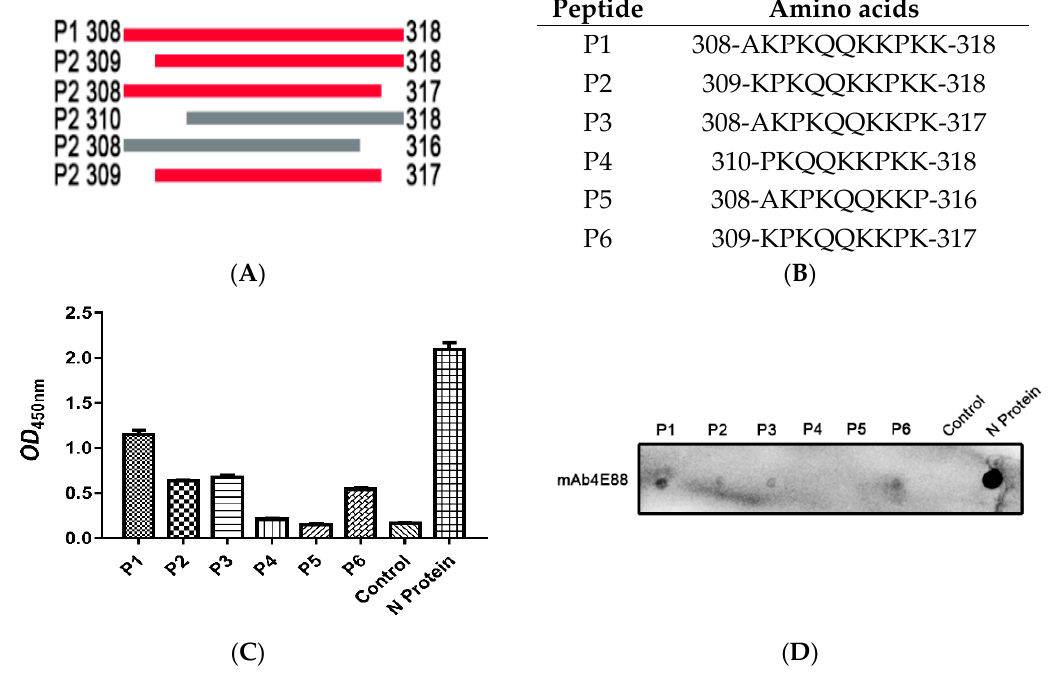
Figure 4. Identification of the minimal 4E88 epitope. Six peptides (P1, P2, P3, P4, P5, P6) were synthesized to detect the minimal epitope ( A , B ) and tested for reactivity with 4E88 by ELISA ( C ) and dot blot assays ( D ). The experiments were repeated three times.